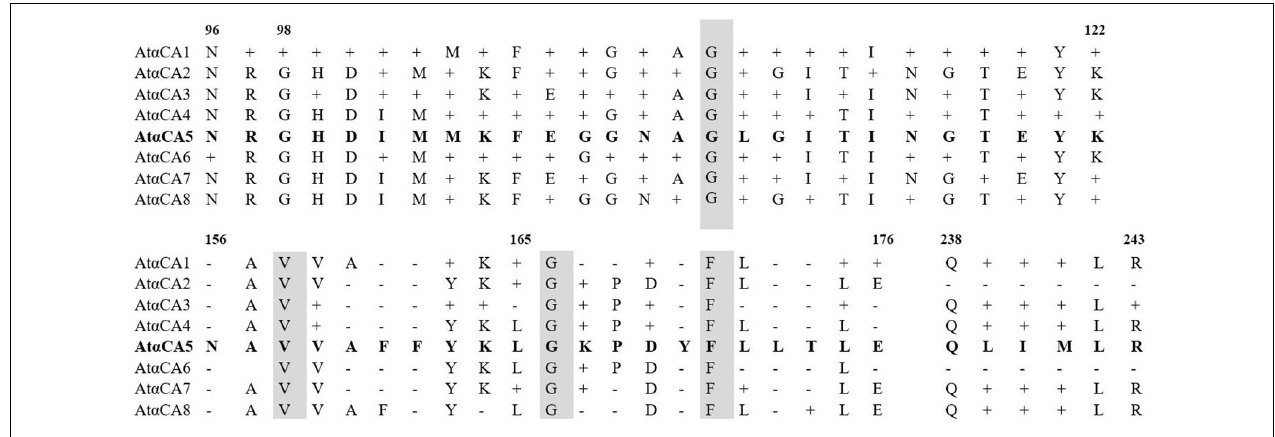
FIGURE 5 | Comparison of the deduced amino acid sequences of α CA1, α CA2, α CA3, α CA4, α CA6, α CA7, and α CA8 with α CA5. Multiple alignment was performed with UniProt (https://www.uniprot.org/blast/). Gray–shaded boxes represent identical amino acids; dashes represent gaps in the alignment.